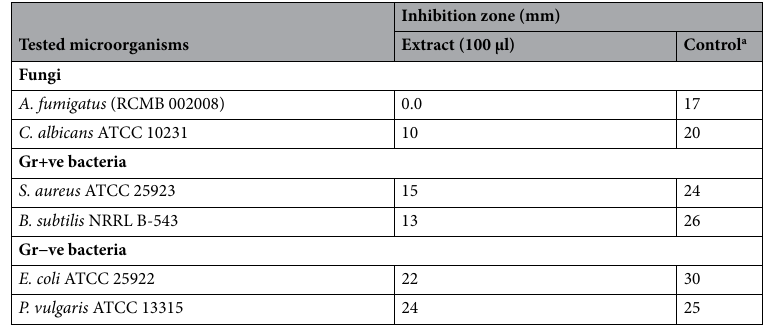
Table 3. Antimicrobial activity of D. caffra fruit extract against clinically important pathogens including fungi, Gram positive and negative bacteria. a Positive control Ketoconazole for fungi and Gentamycin for bacteria. The test was done using the diffusion agar technique, well diameter: 6.0 mm (100 µl was tested).